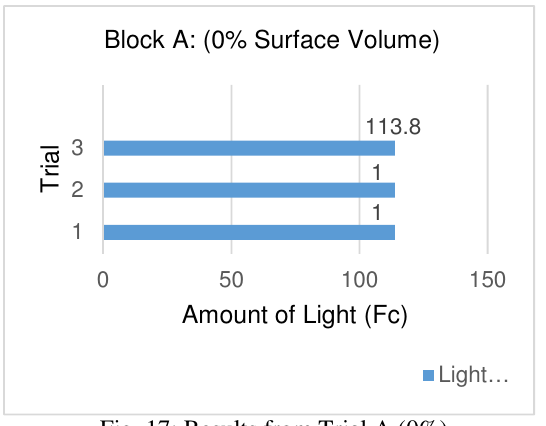
Fig. 17: Results from Trial A (0%)